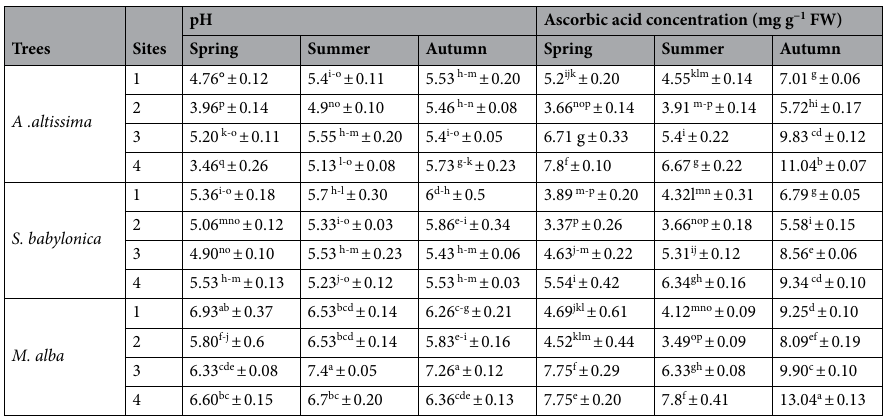
Table 2. Comparison of the air pollution stress effect on the pH and Ascorbic acid concentration (fresh weight, FW) of A. altissima , S. babylonica, and M. alba trees. Three seasons of Spring, Summer, and Autumn at Sites 1 (Mirdamad Street), 2 (Mirza Babaei Street), 3 (Kargar Shomali Street), and 4 (Azadi Bus Station Street) Tehran. The means that have at least one common letter did not show a statistically significant difference ( P < 0.05). Data are presented as mean ± SE.